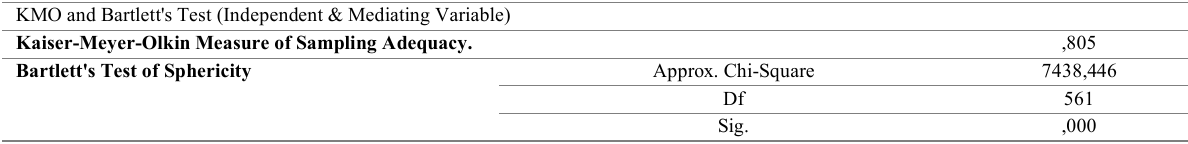
Table 2 : KMO and Bartlett’s Test for Independent and Mediating Variable